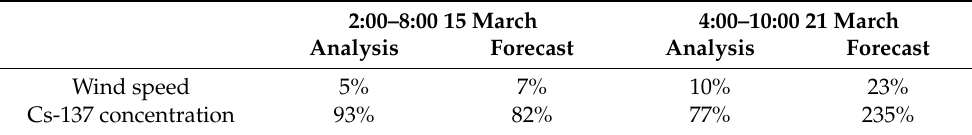
Figure 4. ( a ) Percentile distributions of the 20 ensemble analysis members, where the surface Cs-137 concentration is higher than the threshold (15 Bq/m 3 ). White contour lines indicate the 15 Bq/m 3 concentration of the deterministic analysis member. The open triangle and circle illustrate the locations of the FDNPP and Tokai, respectively. The local time of the snapshots was 2:00, 6:00, and 10:00 on 15 March, respectively. ( b ) Same as ( a ) except for the forecast, which was initiated at 21:00 14 March local time. The forecast duration was 5, 9, and 13 h, respectively. Table 1. Relative Standard Deviations (RSD) a of the 20-member